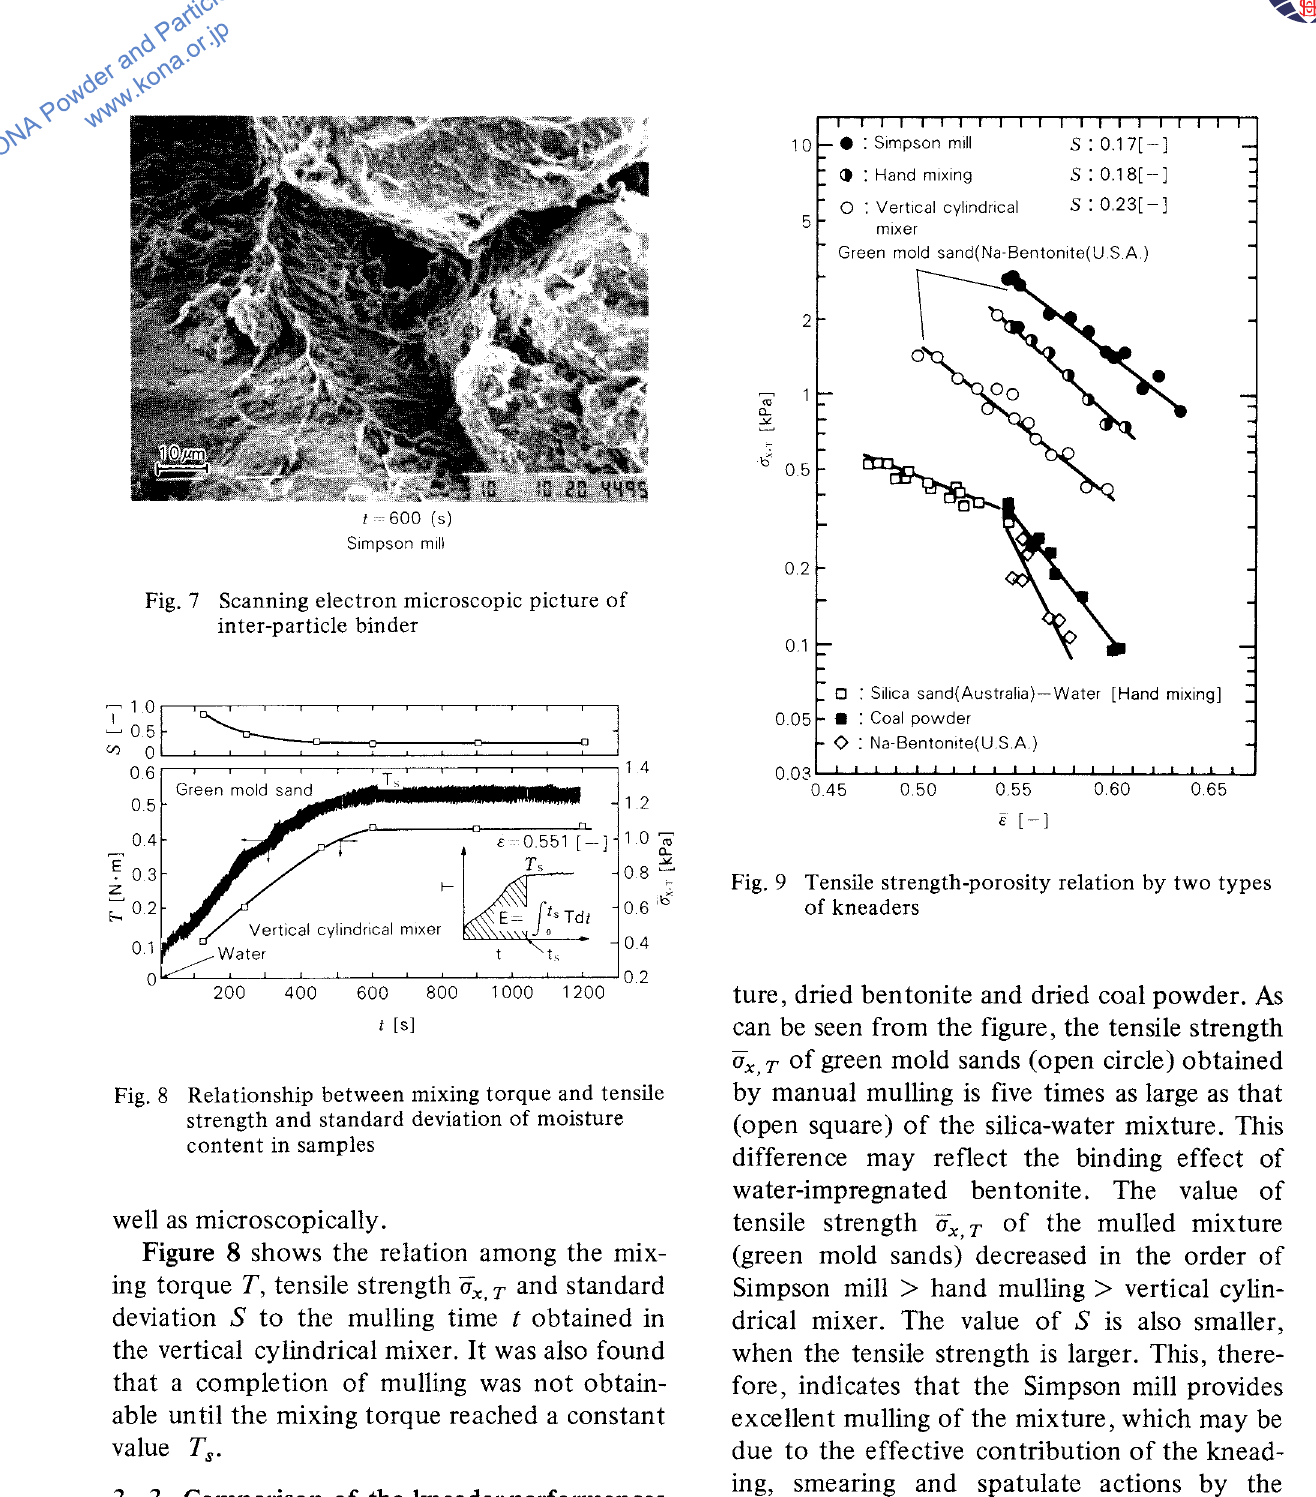
Fig. 9 Tensile strength-porosity relation by two types of kneaders